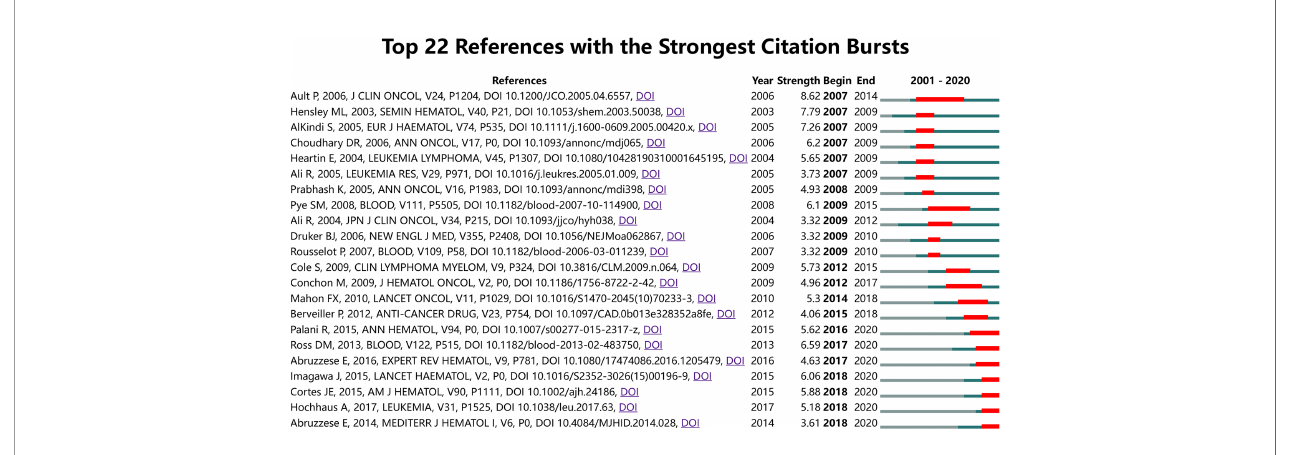
FIGURE 7 | Mutation detection by co – citation analysis (outbreak durations ≥